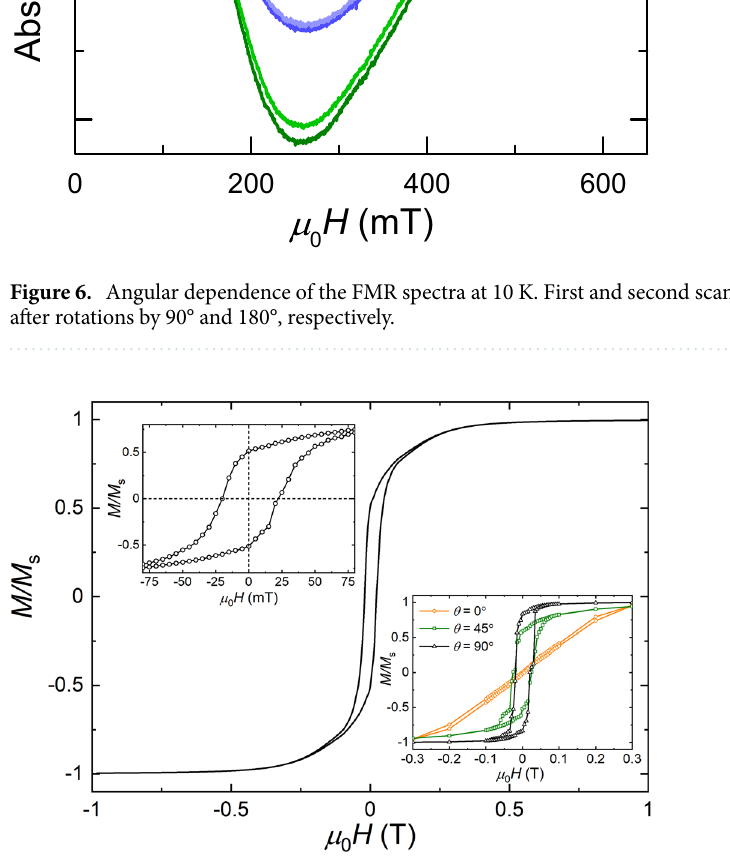
Figure 7. Simulated hysteresis curves. Averaged M ( H ) curve for different flake directions with the angle θ from the normal of the flake ranging from 0° to 90° with steps of 5°, close-up (left insert) and comparison of selected hysteresis curves yielded with θ of 0°, 45°, and 90° (right